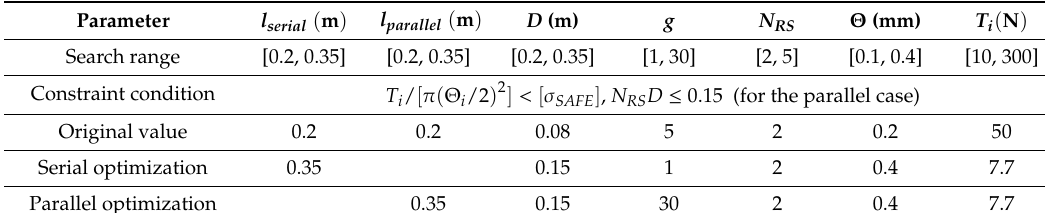
Table 6. Parameter information for multiple-chamber in wide-band optimization.